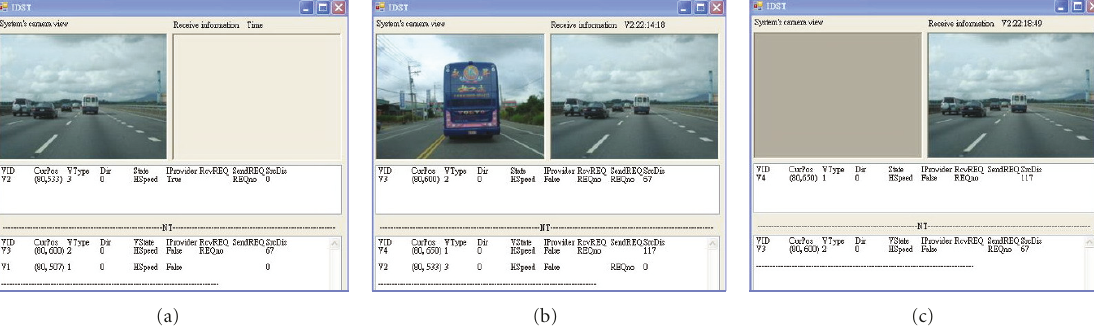
Figure 7: The screen shots of IDST tool executed under the recorded trace mode (a) V2 (b) V3 (c) V4.